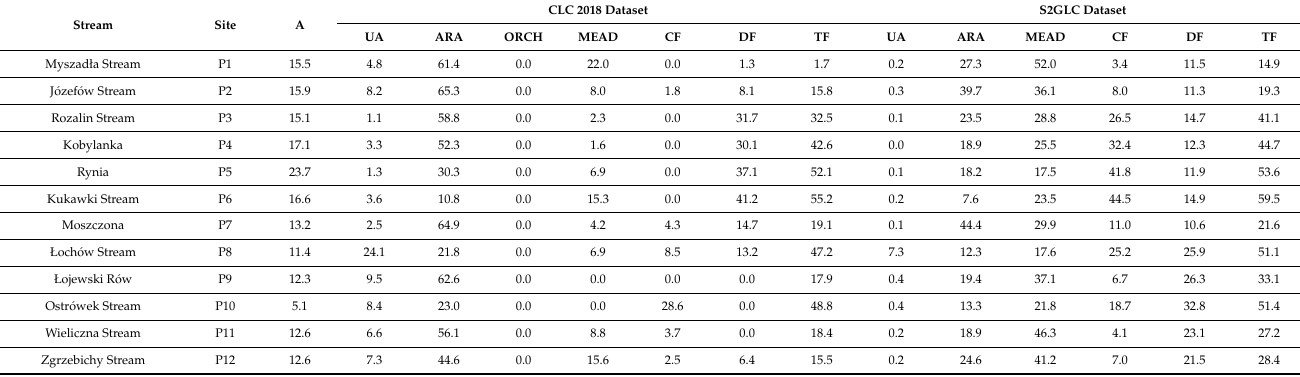
Table A1. Detailed characteristics of catchments in terms of selected land cover types contribution. Abbreviations: A—catchment area [km 2 ], UA—urban areas [%], ARA—arable lands [%],